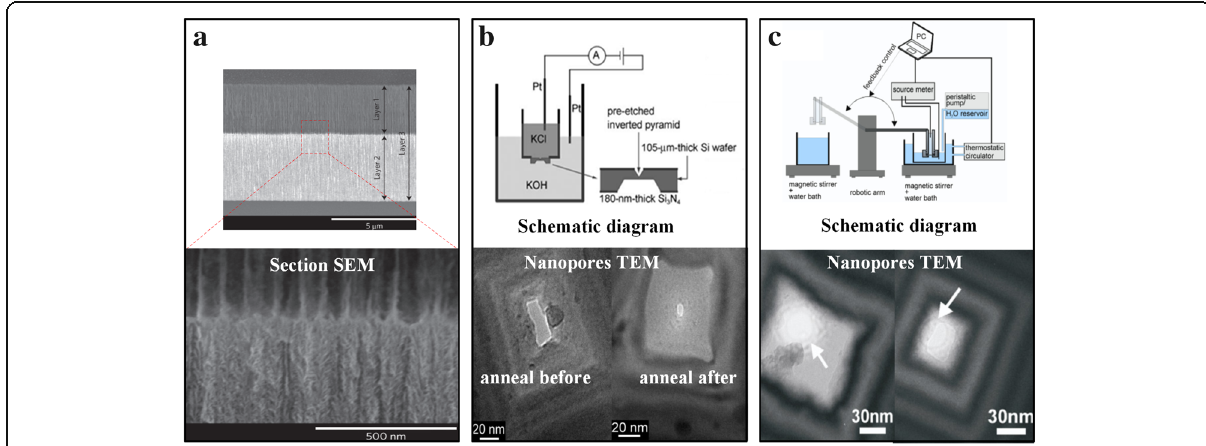
Fig. 3 Preparation of solid-state nanopore by chemical solution etching. ( a ) Double-walled silicon nanopore [38], ( b ) silicon nanopore [27], and ( c ) highly controllable silicon nanopore